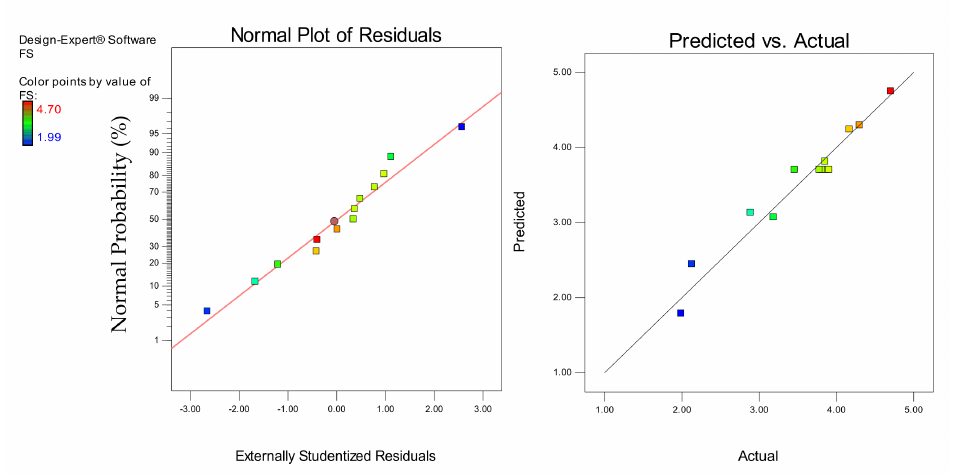
Figure 17. Normal plot of residuals and predicted vs. actual plots for the FS.